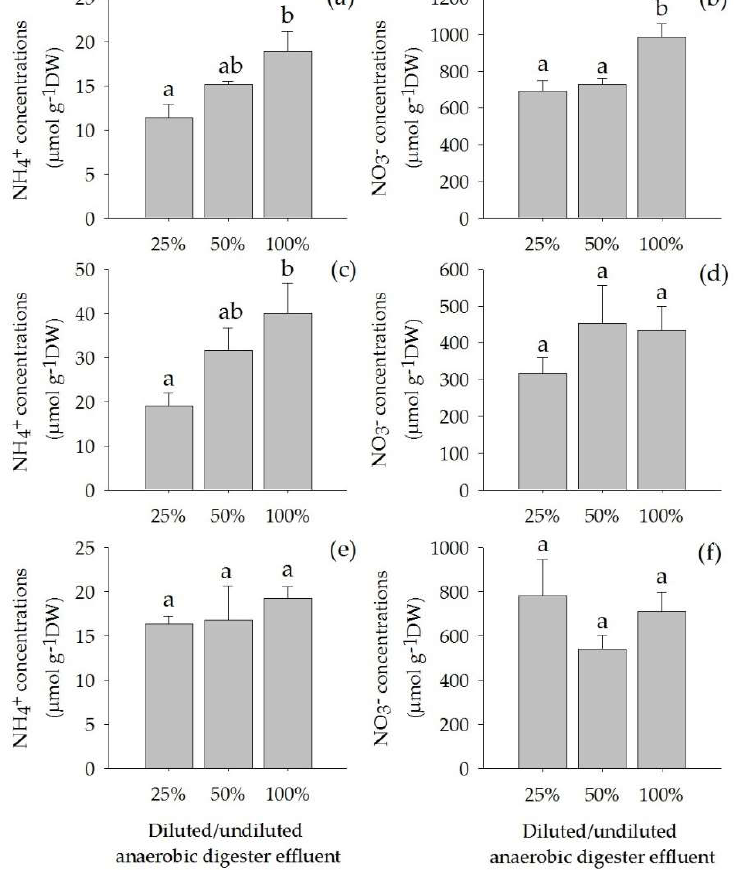
Figure 4. NH 4+ concentration in leaves ( a ), roots ( c ) and rhizomes ( e ) and NO 3− concentrations in leaves ( b ), roots ( d ) and rhizomes ( f ) (Mean ± SE) of Acorus calamus grown on diluted anaerobic digester effluent (25% and 50%) and undiluted anaerobic digester effluent (100%) for a period of 56 days. Different letters indicate significant differences among treatments.